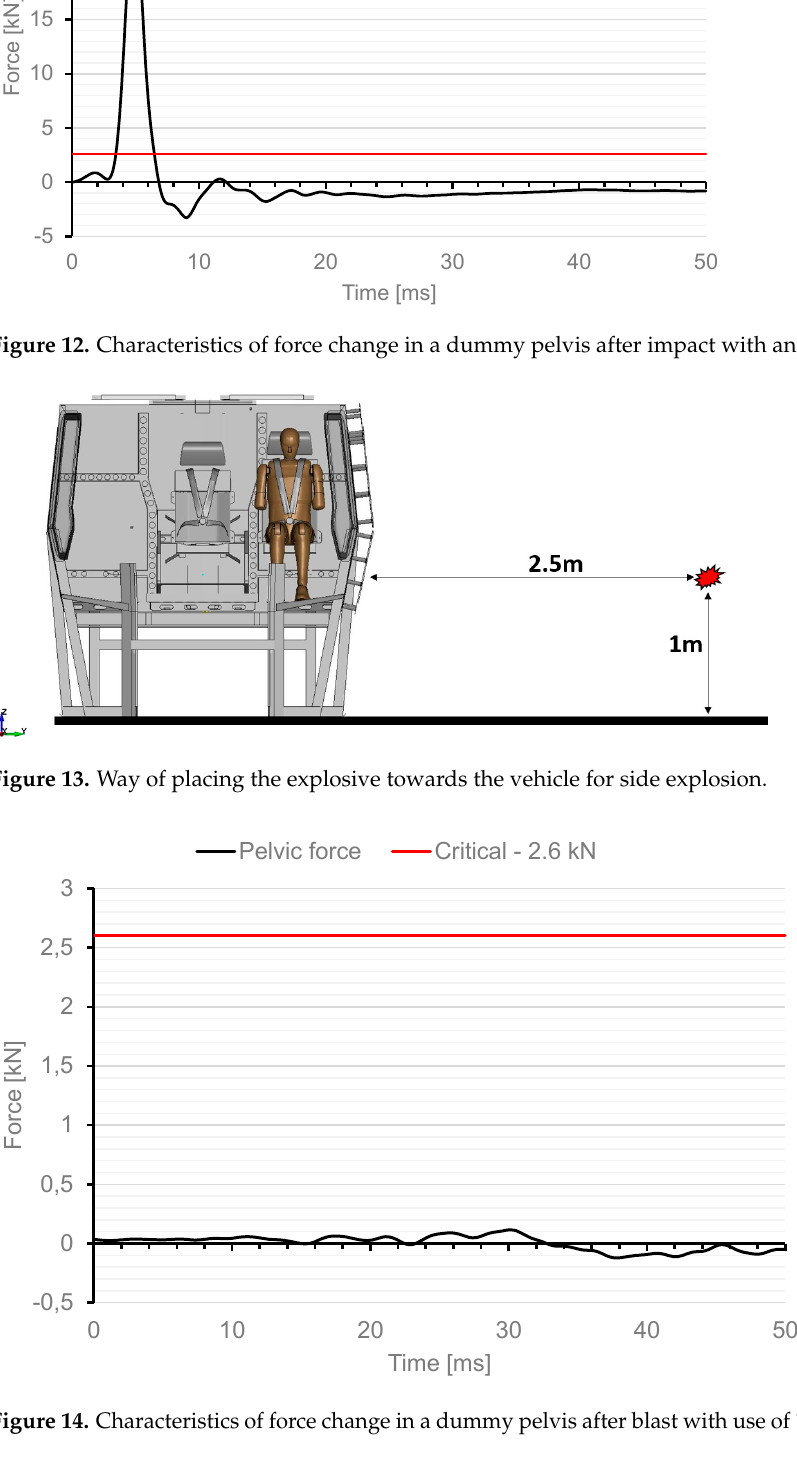
Figure 12. Characteristics of force change in a dummy pelvis after impact with an impactor.